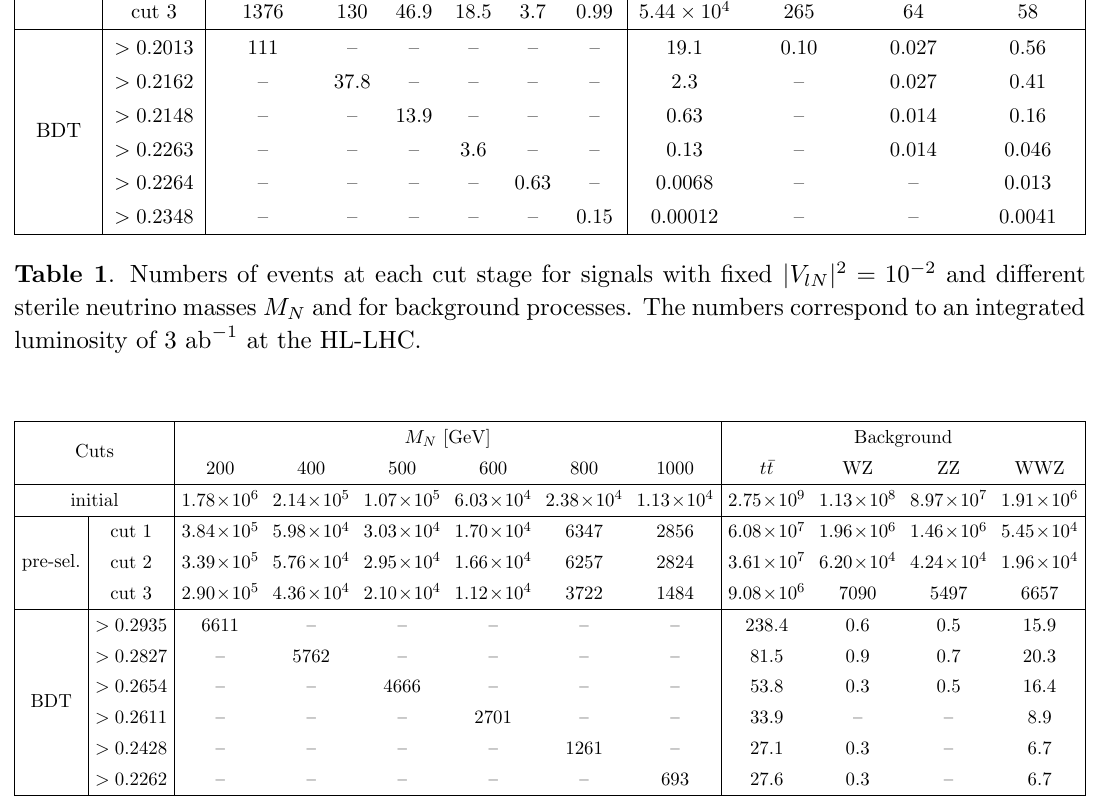
Table 2 . Numbers of events at each cut stage for signals with (cid:12)xed j V lN j 2 = 10 (cid:0) 2 and di(cid:11)erent sterile neutrino masses M N and for background processes. The numbers correspond to an integrated luminosity of 20 ab (cid:0) 1 at the